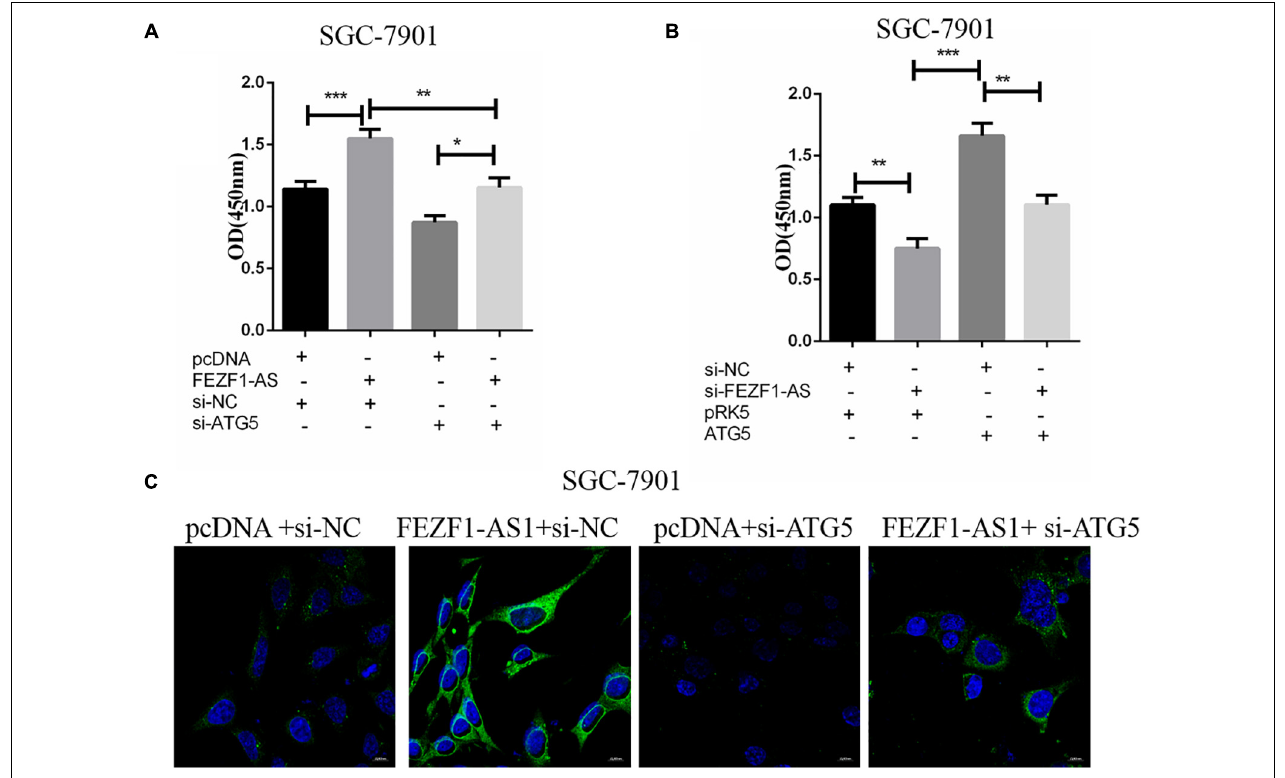
FIGURE 5 | ATG5 knockdown inhibited autophagy of GC cells promoted by overexpression of LncFEZF1-AS1. (A) CCK8 assay on the proliferation of SGC-7901 cells with or without the treatment of FEZF1-AS1, FEZF1-AS1 + ATG5 siRNA or their control. (B) The proliferation of SGC-7901 with or without the treatment of FEZF1-AS1 siRNA, FEZF1-AS1 siRNA + ATG5 or their control group analyzed by CCK8 assay. (C) Representative images of LC3 puncta formation in SGC-7901 observed via IF staining, green: LC3B, bule: DAPI, scar bar: 20 mM. The results represented the mean ± SD of 3 independent experiments. * P < 0.05, ** P < 0.01, *** P <